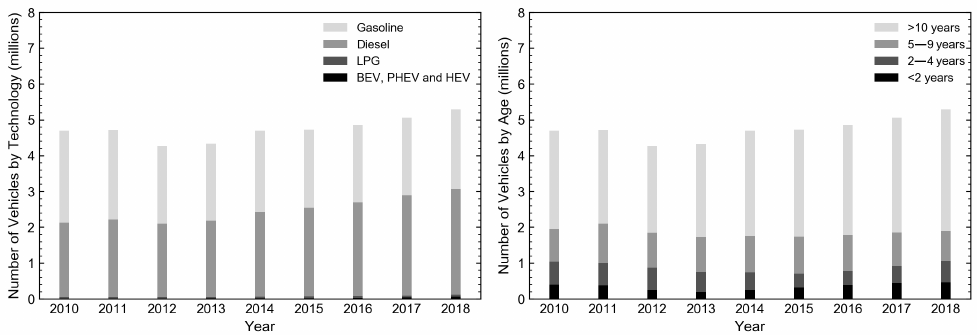
Figure 9. Portuguese car stock composition by technology ( left ) and car age ( right